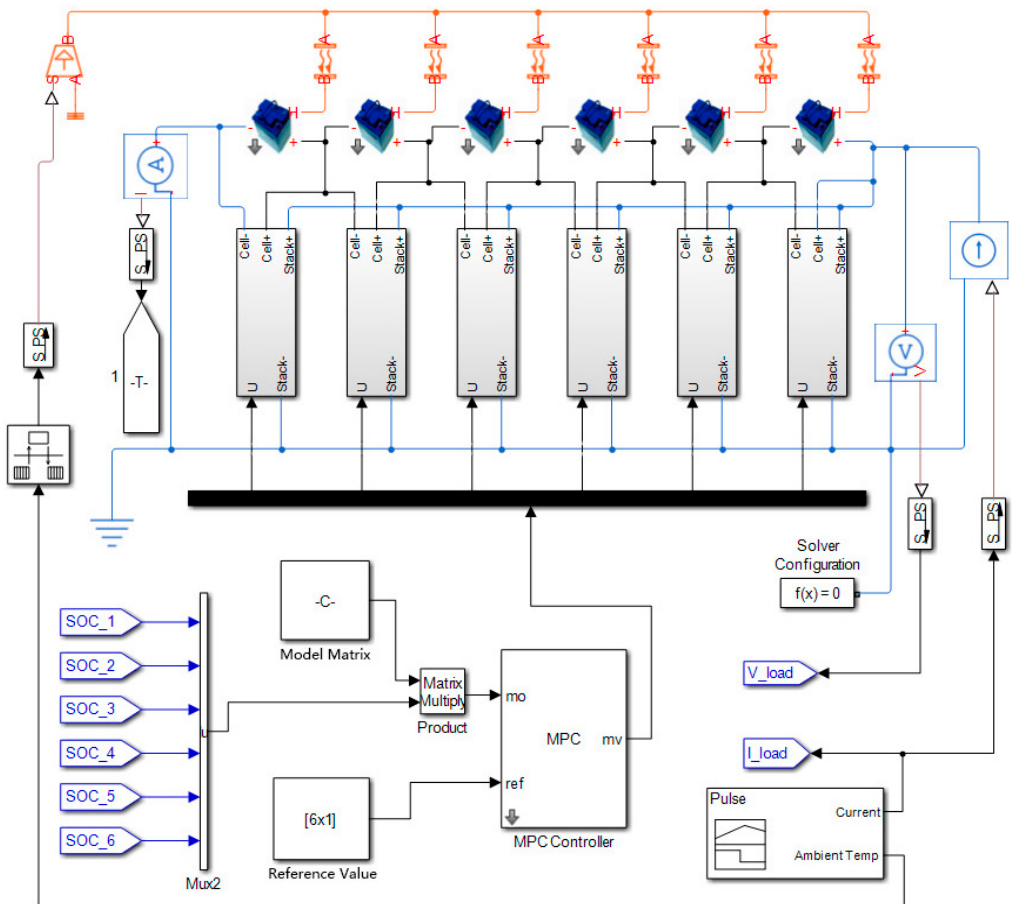
Figure 20. Distributed DC–DC equalisation model.